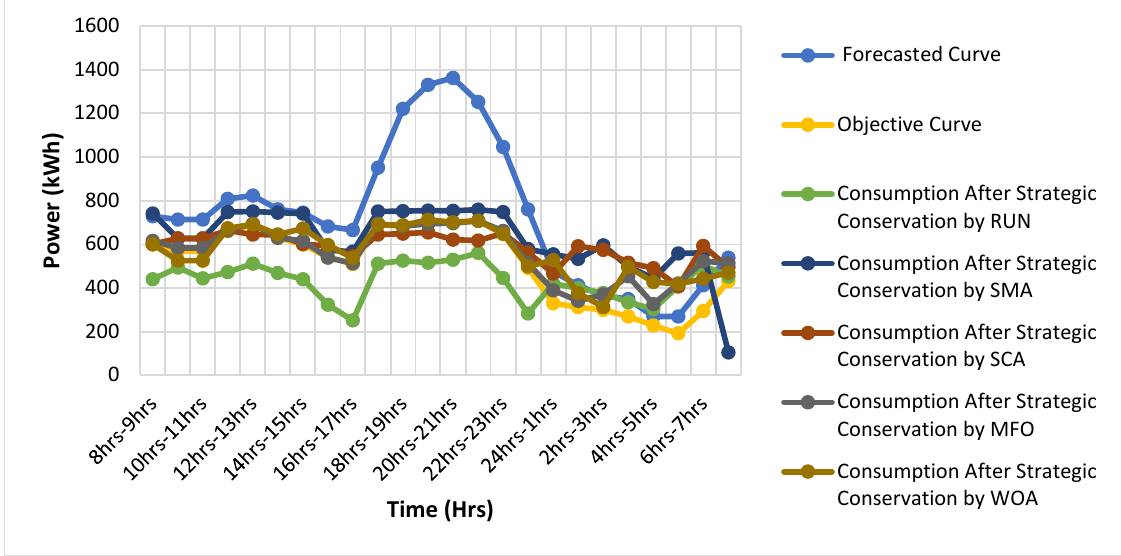
Figure 7. Strategic conservation curves for residential consumers.